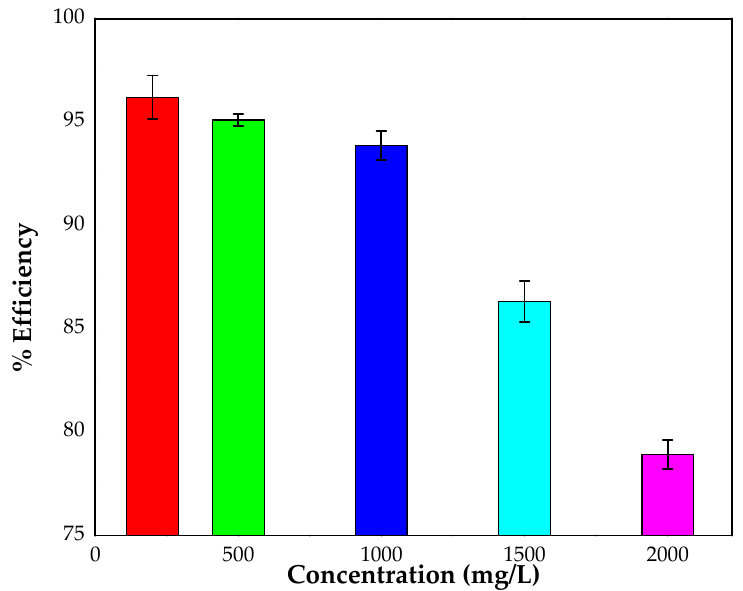
Figure 8. Effect of initial alizarin concentration on the extraction efficiency by DES-3 (pH = 6.37, contact time = 5 min, DES dosage = 0.15 mL at 25 °C).